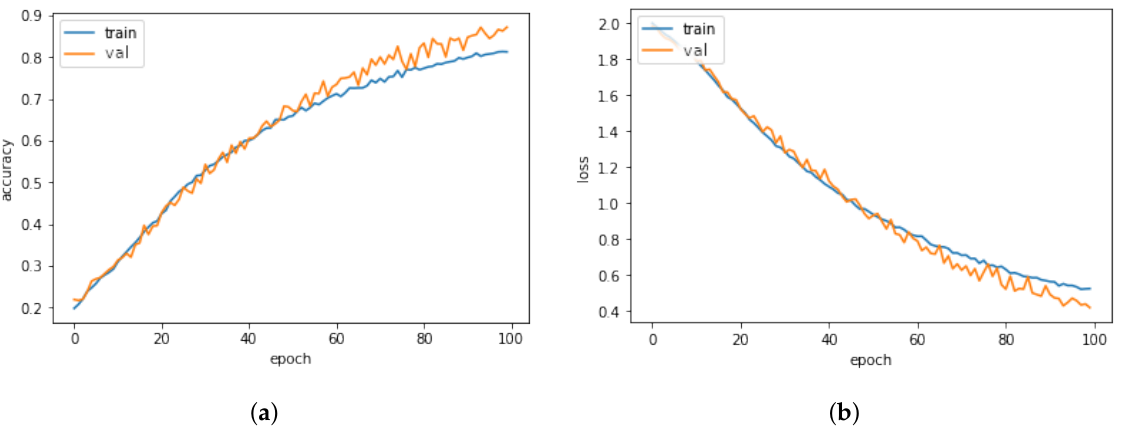
Figure 8. Learning curve: ( a ) Accuracy vs. Epoch; ( b ) Loss vs.